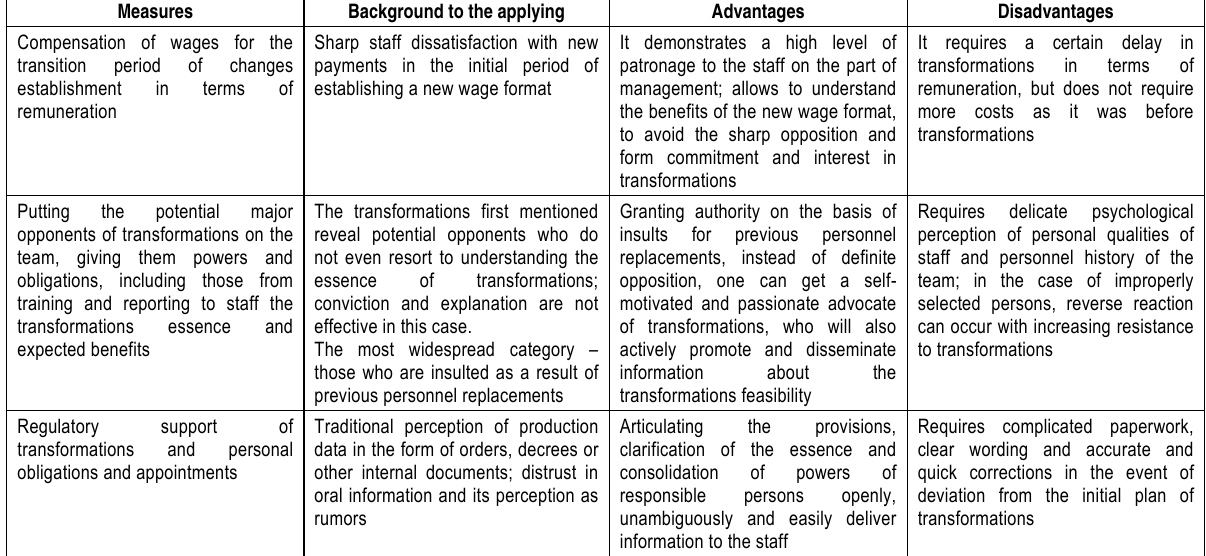
Table 1 (cont.). The ways to overcome staff opposition to the